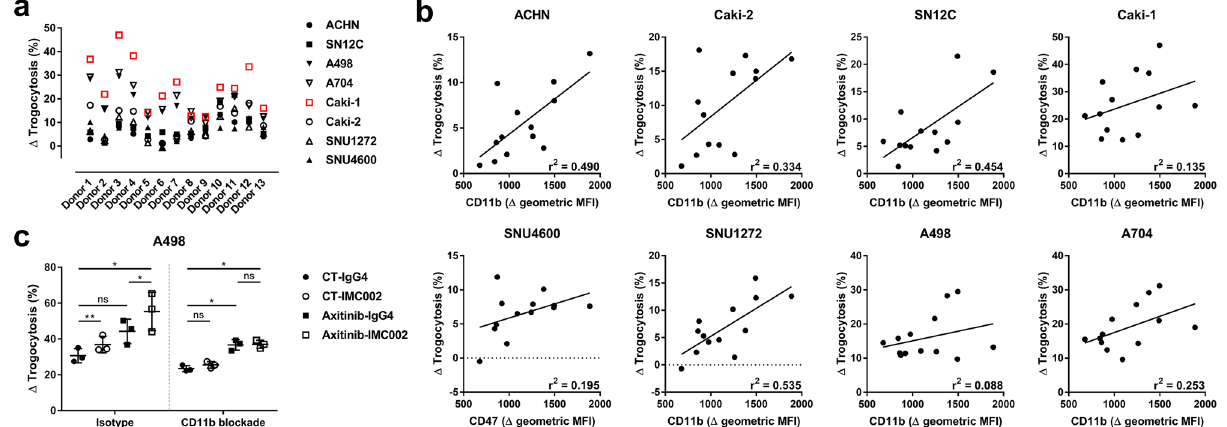
Figure 5. The relevance between CD11b expression level and increased levels of trogocytosis induced by CD47 blockade. ( a ) Graph showing the CD47 blockade-induced trogocytosis (%) organized by each donor. ( b ) Graphs representing the correlation between the CD11b surface expression in macrophages (x-axis) and Δ trogocytosis due to CD47 blockade (y-axis) in each RCC cell line. ( c ) Dot and whisker plot showing trogocytosis (%) of macrophages against A498 cells without and with CD11b blocking (n = 3). Each phagocytosis of macrophages is marked by separate dots for donors, and the means ± SD is plotted on the graph. * P < 0.05; ** P < 0.005 (two- tailed t